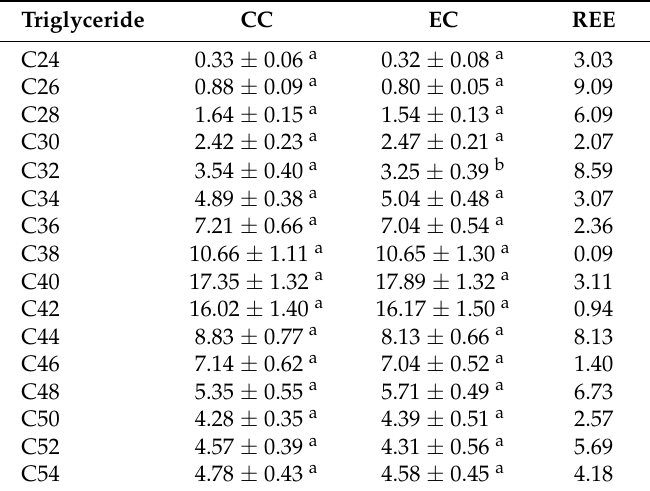
Table 3. Triglycerides composition (g/100 g fat) from the control and the experimental Manchego cheese by the effect of the β -CD.